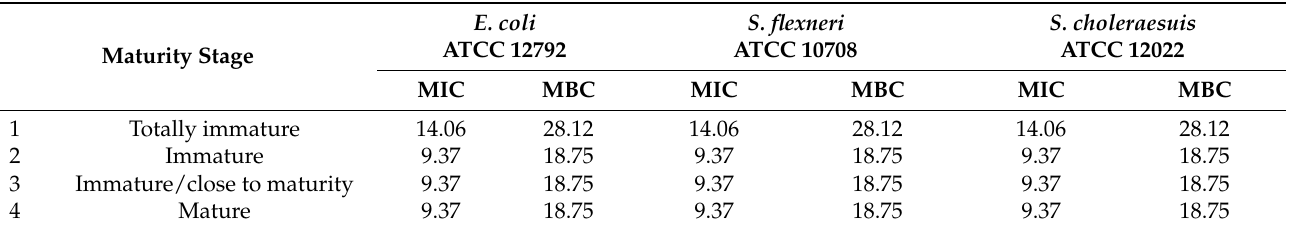
Table 7. Antimicrobial activity of methanolic extracts of Vaccinium stenophyllum Steud. fruits during maturation for E. coli , S. flexneri, and S. choleraesuis .